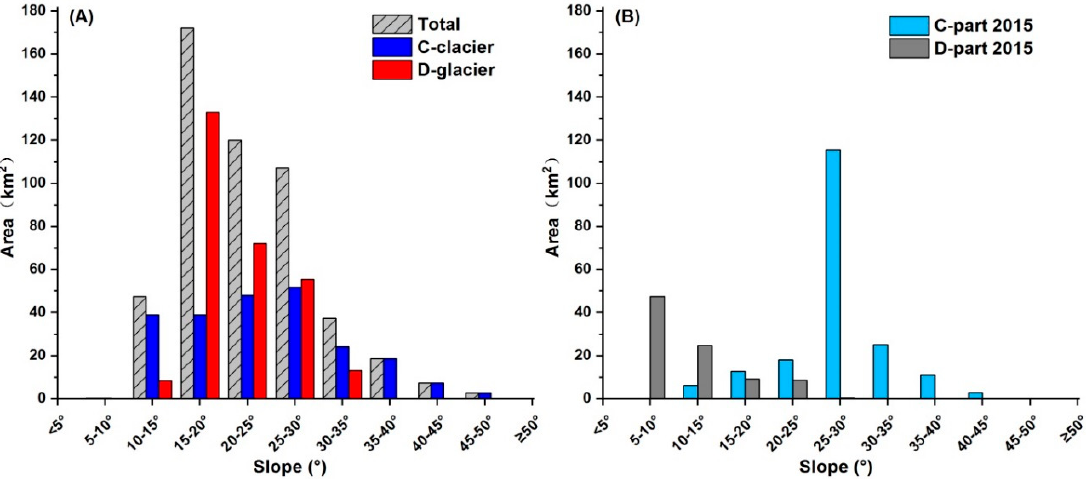
Figure 6. Area distribution of glaciers at various slope classes in 2015: ( A ) area distributions of C-glaciers and D-glaciers; ( B ) area distributions of C-part and D-part of D-glaciers. The average slope was calculated based on DEM with a 30 m spatial resolution for individual C-glacier, D-glacier, C-part and D-part glaciers, and then we summed the area for each class.